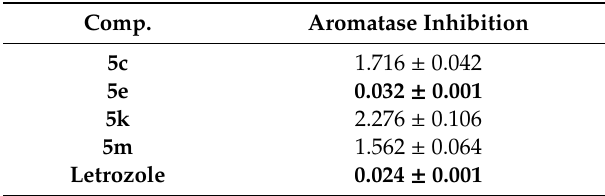
Table 3. IC 50 ( µ M) values of compounds 5c , 5e , 5k , 5m, and letrozole. Comp. Aromatase